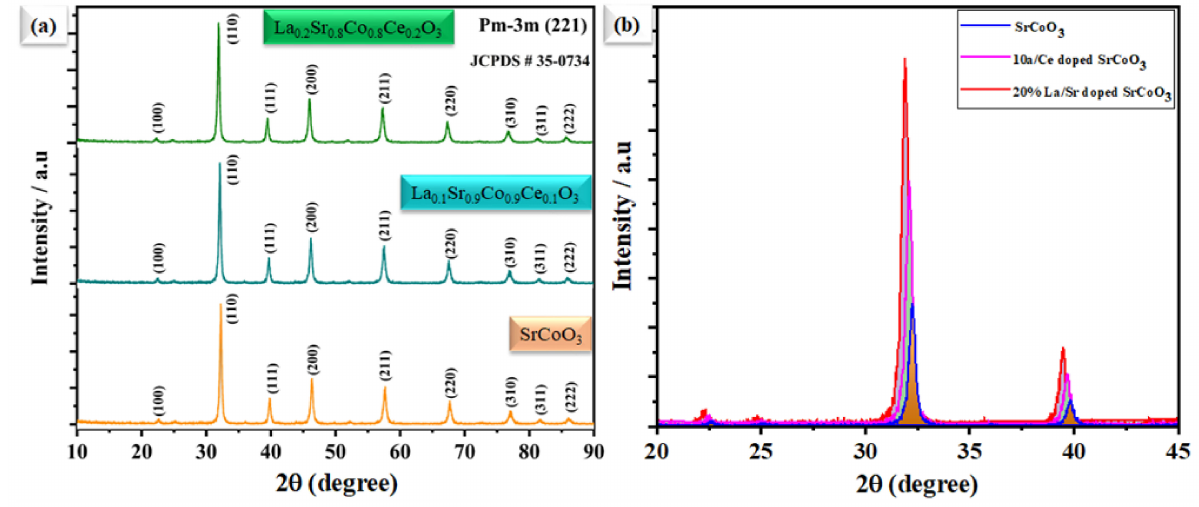
( a ) The X-ray diffraction pattern of SrCoO 3 , La 0.1 Sr 0.9 Co 0.9 Ce 0.1 O 3 − δ , and La 0.2 Sr 0.8 Co 0.8 Ce 0.2 O 3 − δ , respectively. ( b ) The comparison main of peak shifting of SrCoO 3 with La and Ce